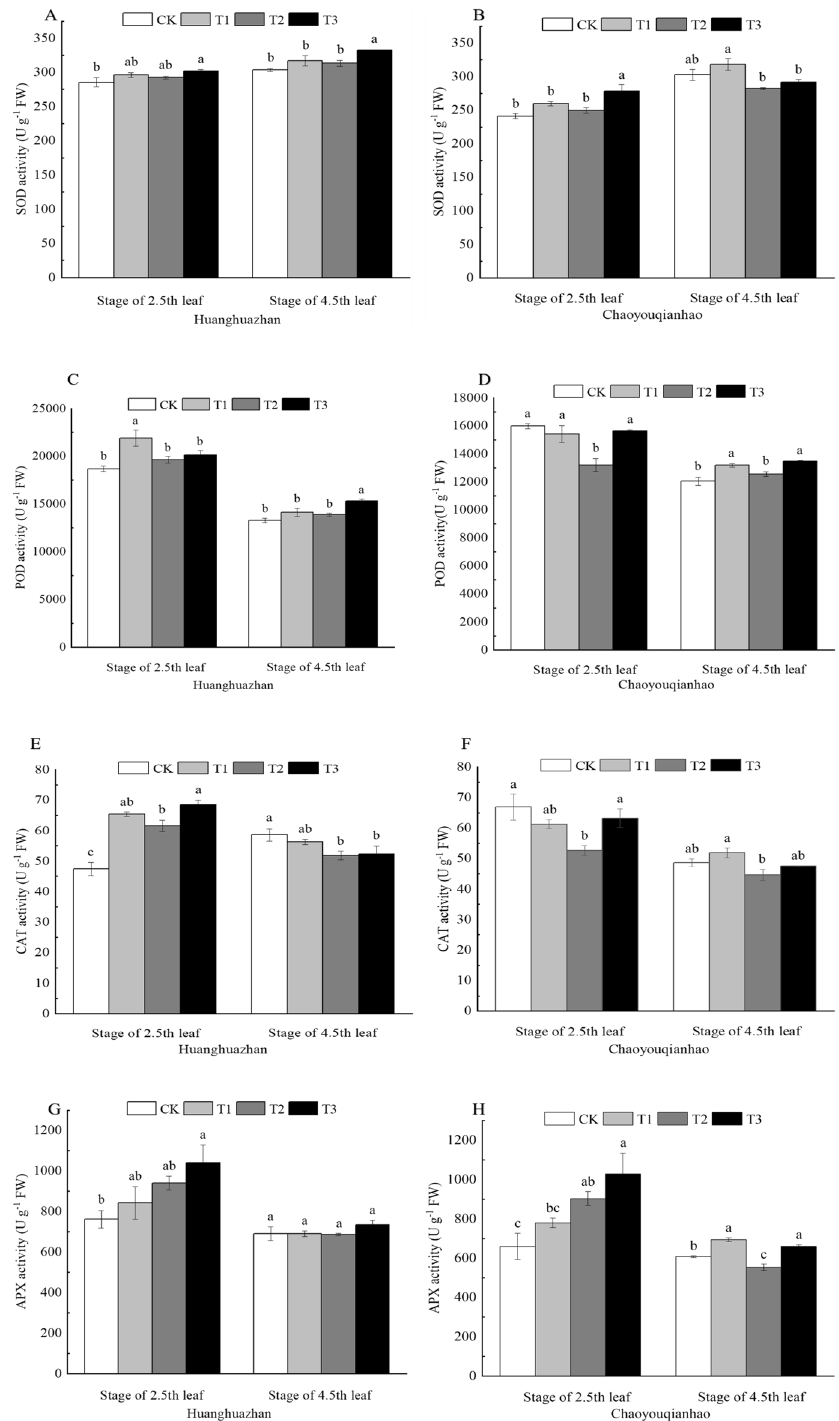
Figure 5. Effects of soaking with BR on antioxidant enzyme activities of rice seedlings under salt stress. Different lowercase letters indicate significant differences at the P < 0.05 level. CK: soaking with distilled water + watering 0 g L −1 NaCl. T1: soaking with BR + watering 0 g L −1 NaCl. T2: soaking with distilled water + watering 3 g L −1 NaCl. T3: soaking with BR + watering 3 g L −1